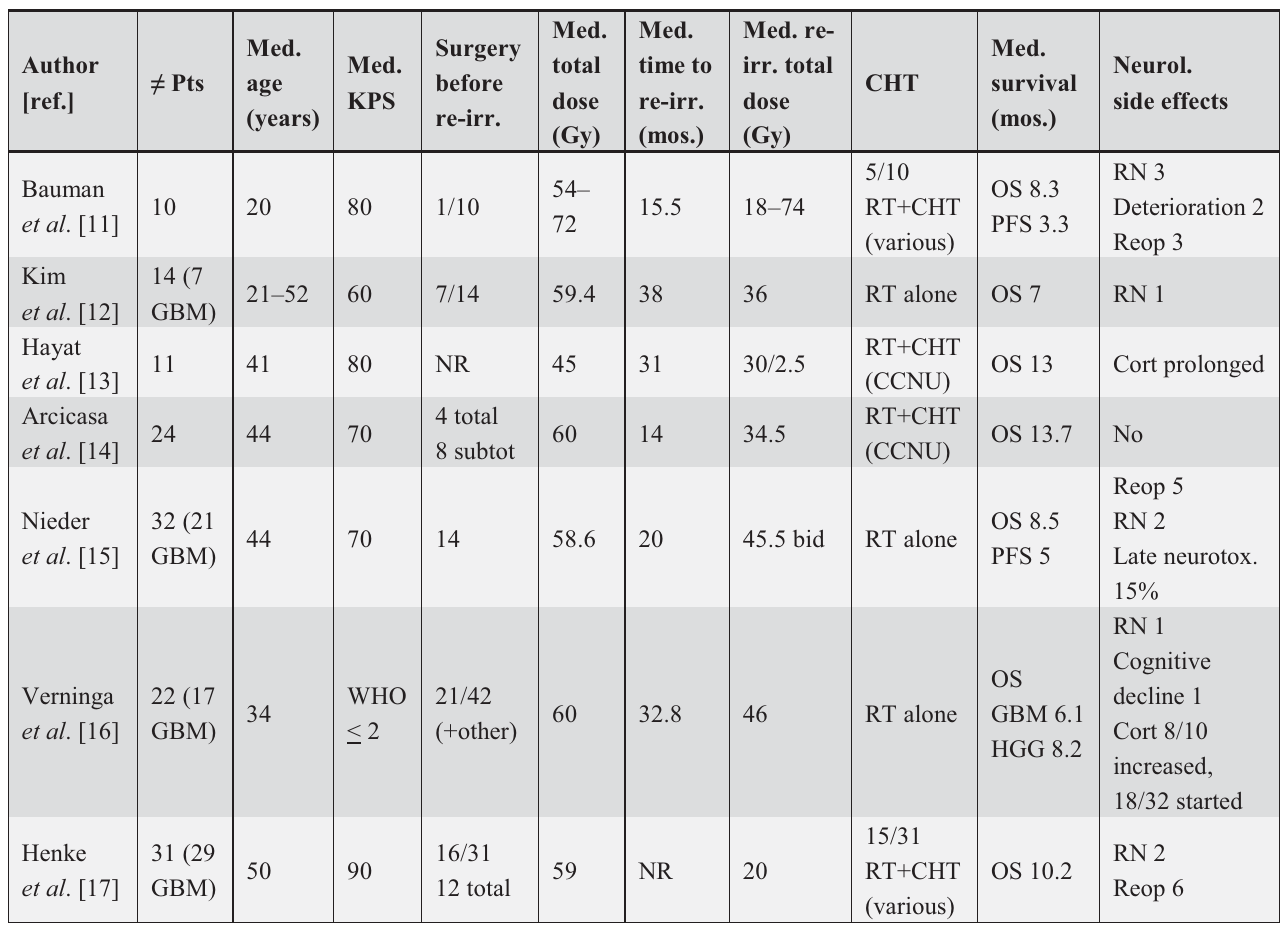
Table 1. Re-irradiation with external beam radiotherapy with or without